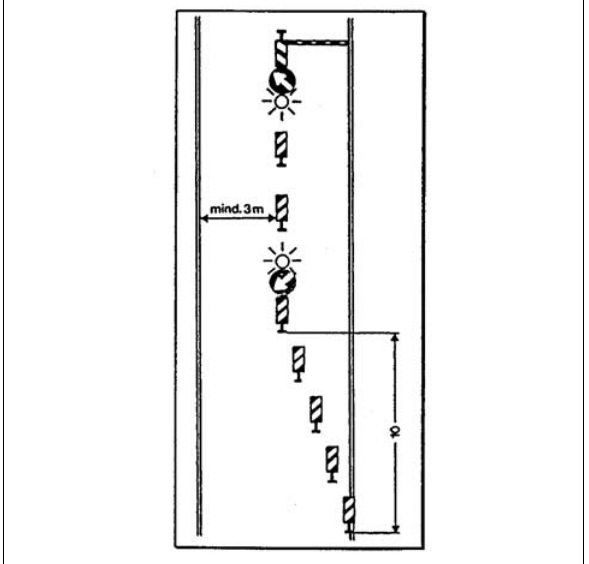
Fig 3. A general rule plan of safety device on building sites